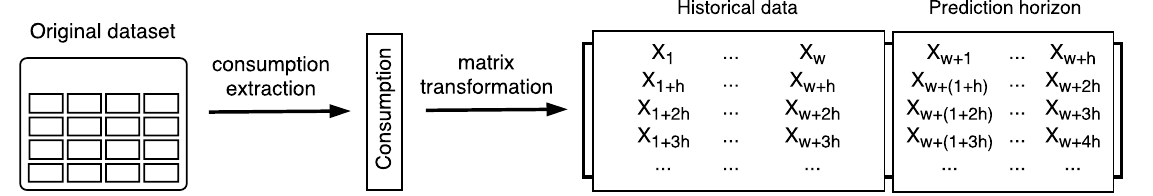
Figure 4. Dataset pre-processing. w determines the amount of the historical data used, while h determines the prediction